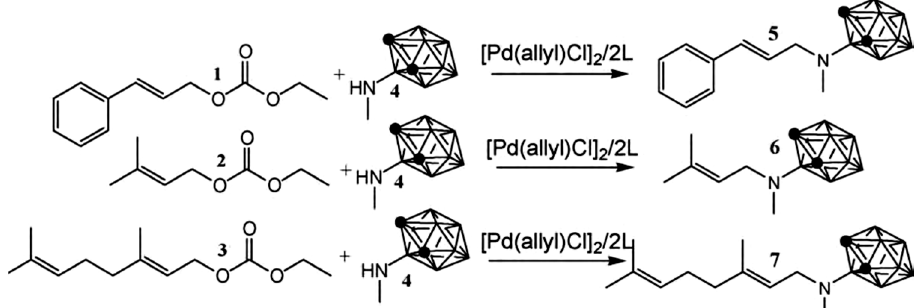
Figure 20. Allylic amination with N -(ortho-carboran-3-yl)- N -methylamine: N -Cinnamyl- N -(ortho- carboran-3-yl)methylamine ( 5 ), N -(3-Methylbut-2-enyl)- N -(ortho-carboran-3-yl)methylamine ( 6 ), ( E )- N -(3,7-Dimethylocta-2,6-dienyl)- N -(ortho-carboran-3-yl)methyl amine ( 7 ). Reprinted from [55] with permission from Elsevier.